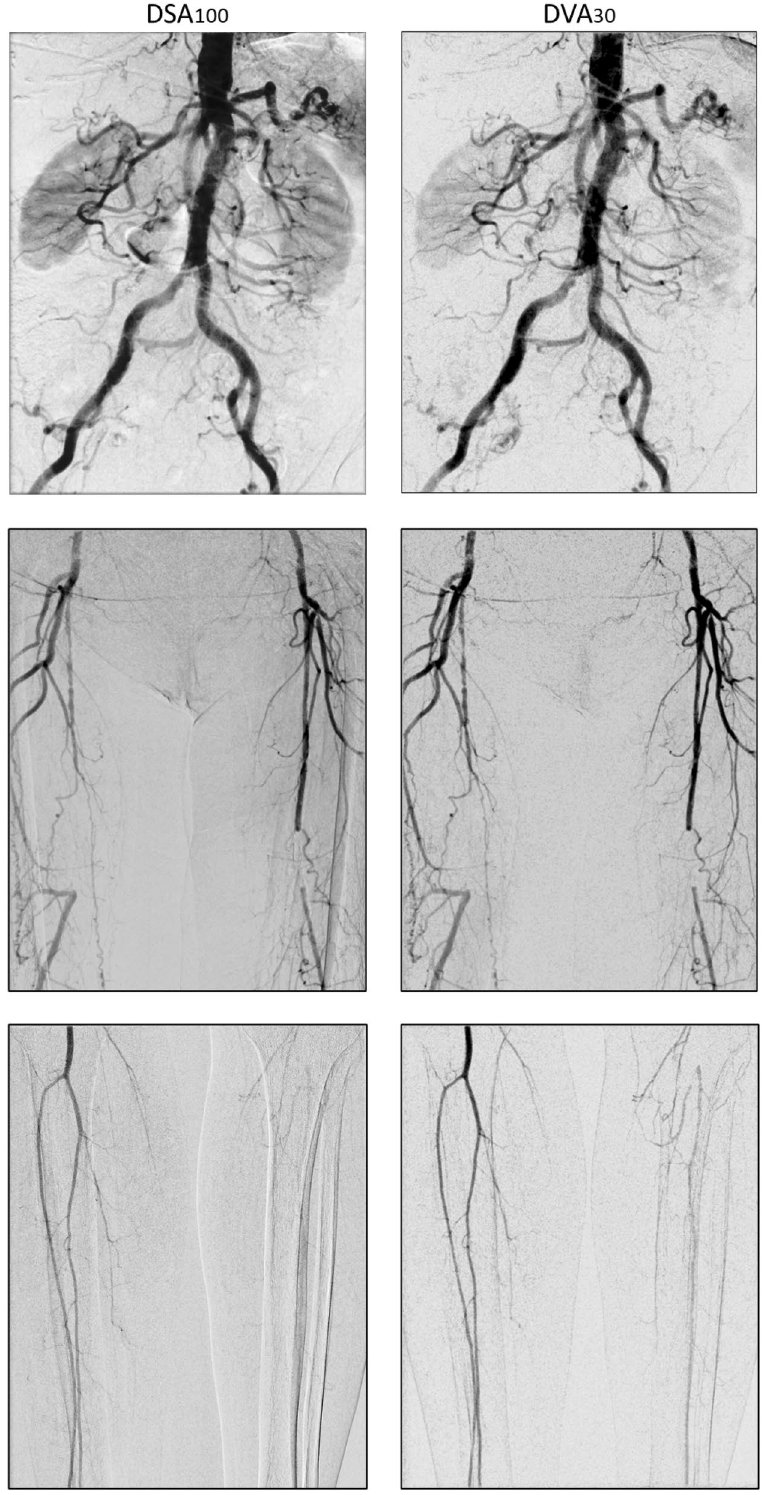
Figure 4. Comparison of representative normal dose (1.2 µGy/frame) DSA100 (left column) and low-dose (0.36 µGy/frame) DVA30 (right column) images obtained in the abdominal (upper row), femoral (middle row) and crural (lower row) region. The corresponding Image pairs were taken from the same patient and same direction in two consecutive runs, but the different regions belong to different patients. Brightness/contrast adjustments and pixel shift were applied to DSA and DVA images using the Siemens Syngo and the Kinepict workstation, respectively. Abbreviations: DSA: Digital Subtraction Angiography; DVA: Digital Variance